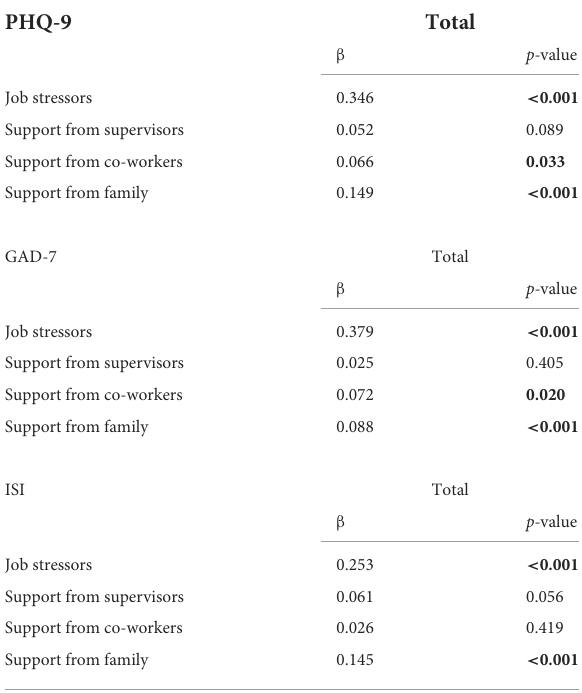
TABLE 4 Linear regression analysis of PHQ-9, GAD-7, and ISI.